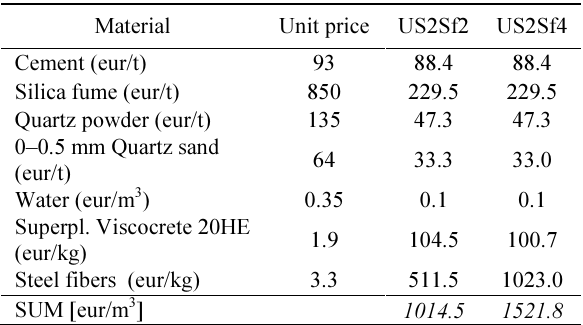
Table 3. Unit prices of component materials and composites